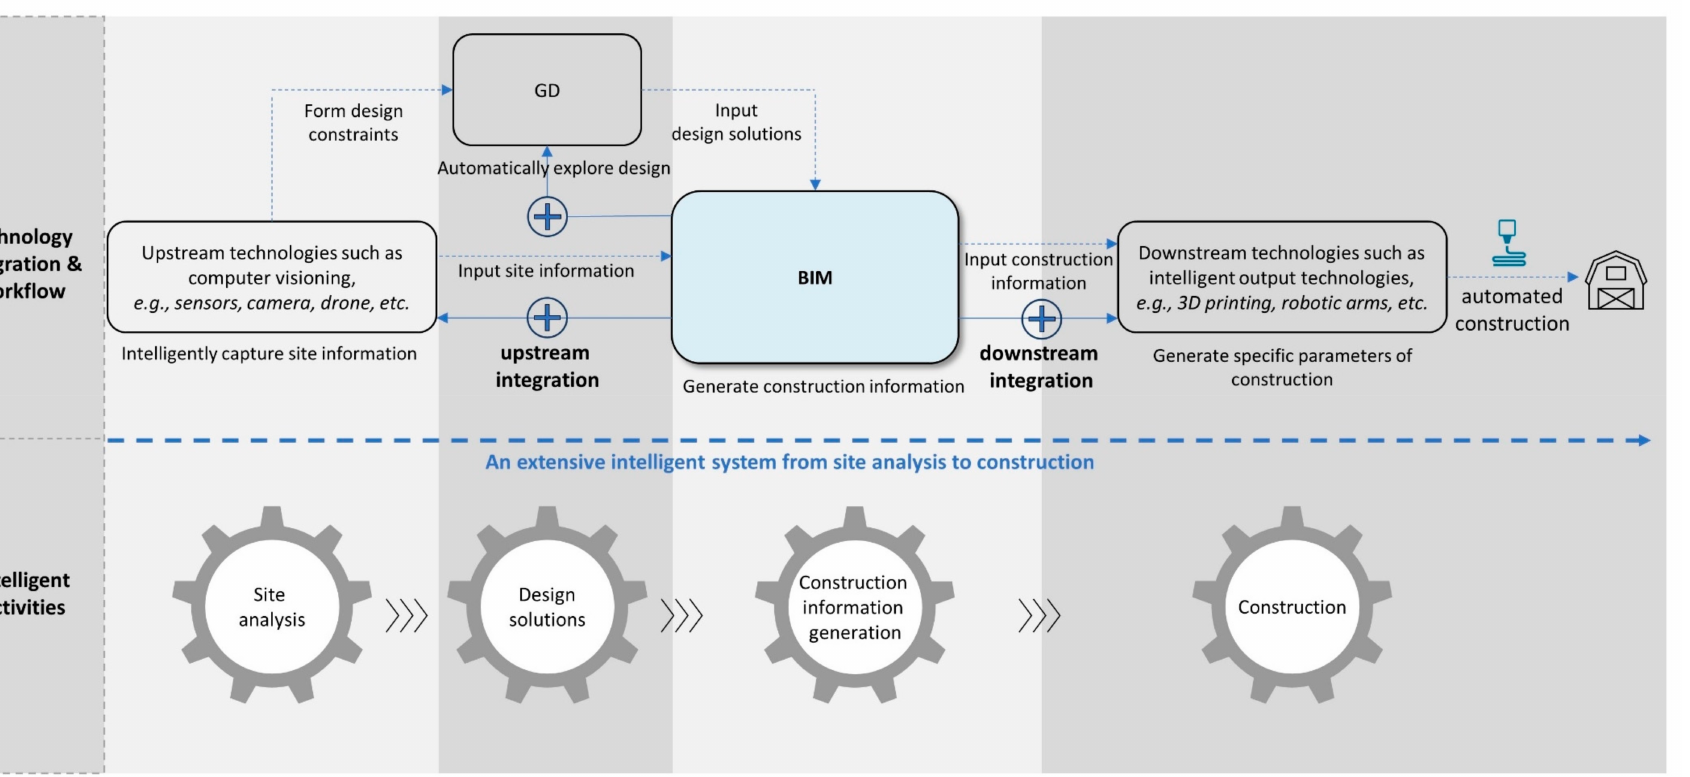
Figure 6. A framework of an extensive intelligent system (from site analysis to construction) formed by broad technology integration based on